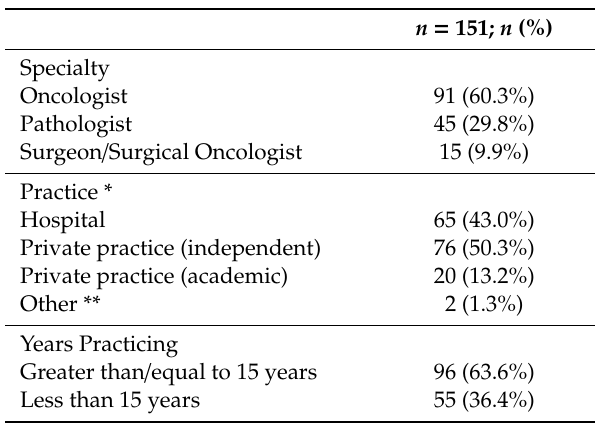
Table 1. Physician